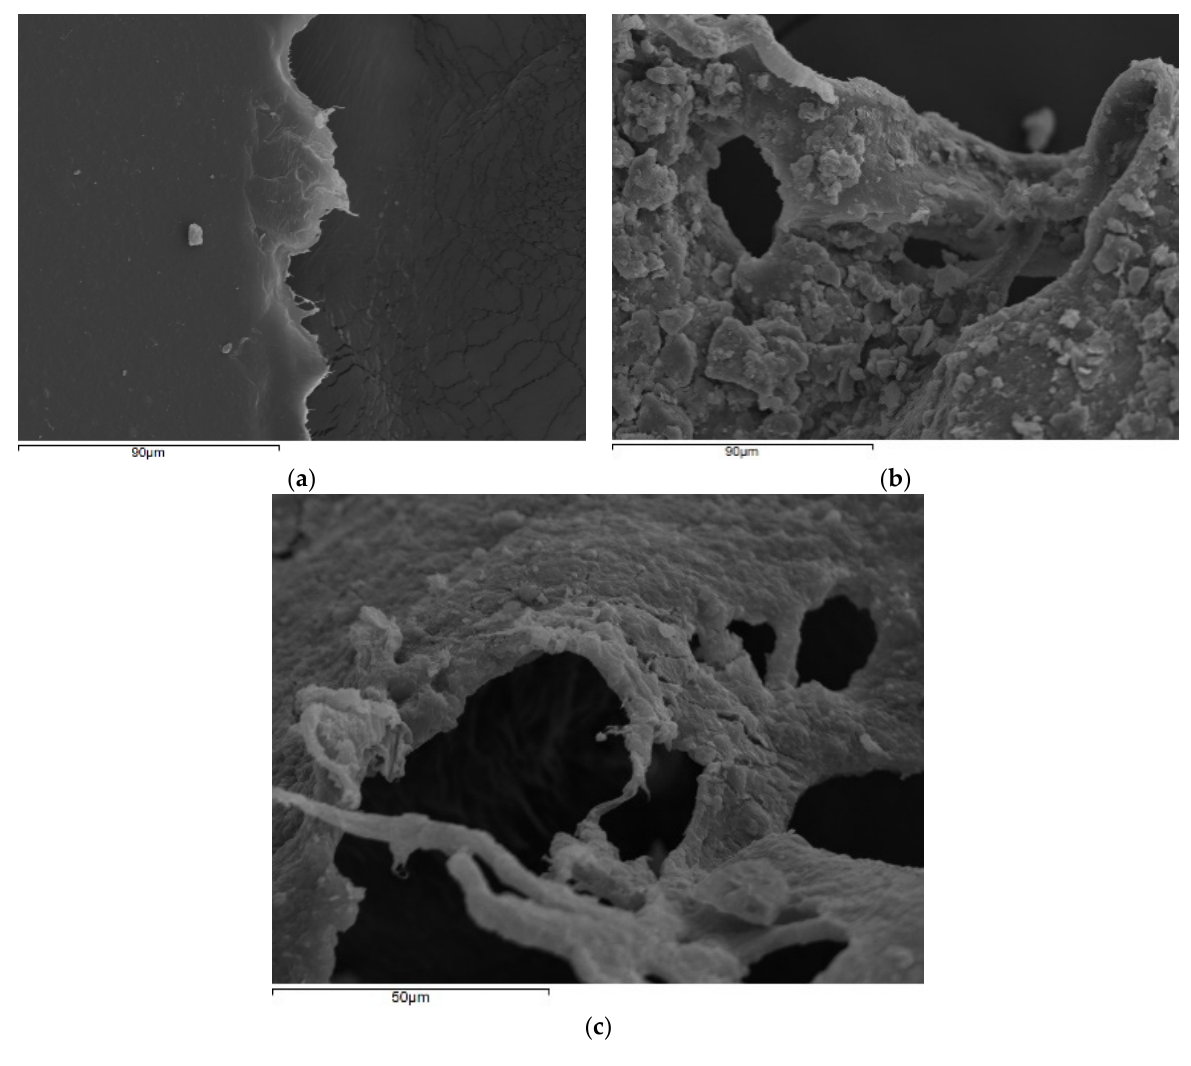
Figure 5. SEM images of ( a ) virgin BMF, ( b ) used BMF, and ( c ) MP